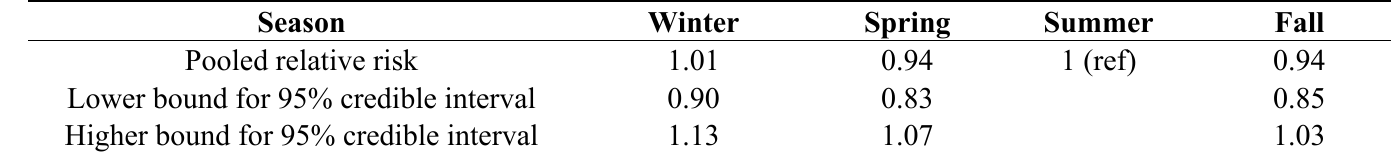
Table A19. Pooled relative risks and 95% credible interval for the association between season of birth and preterm birth.